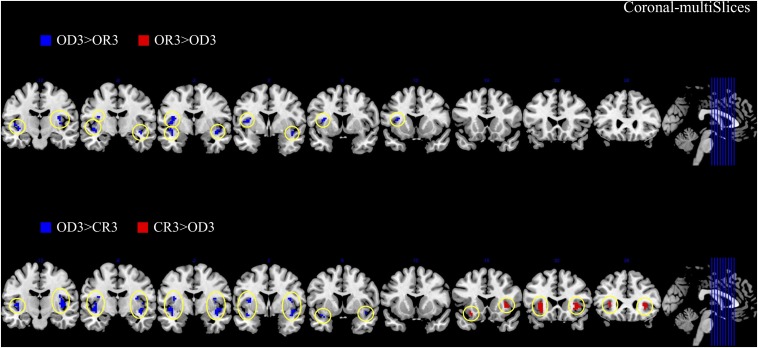
The anterior and posterior insular activations observed after the application of creative reappraisals (CR) and objective descriptions (OD) (coronal plane).